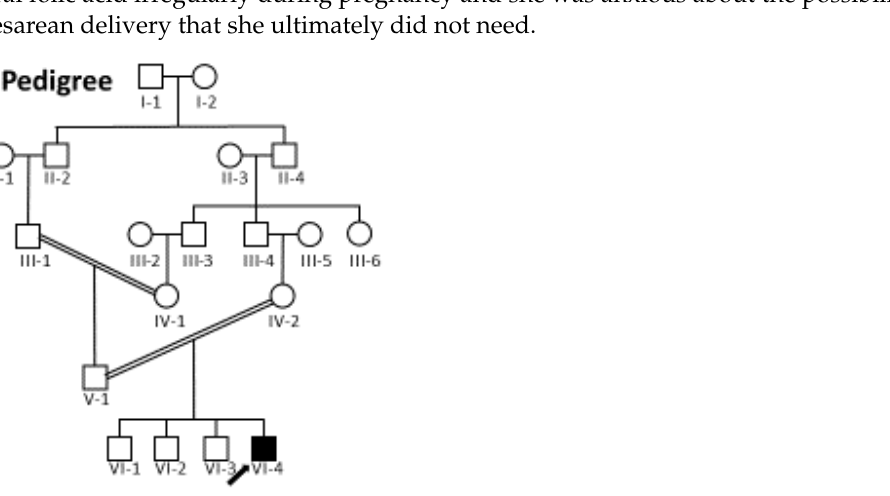
Figure 1. Pedigree. The proband is individual VI-4 and comes from a consanguineous marriage (parents are double second cousins). Black means affected and arrow indicates the proband recruited. There was no history of any psychiatric or neurodevelopmental disorder in the